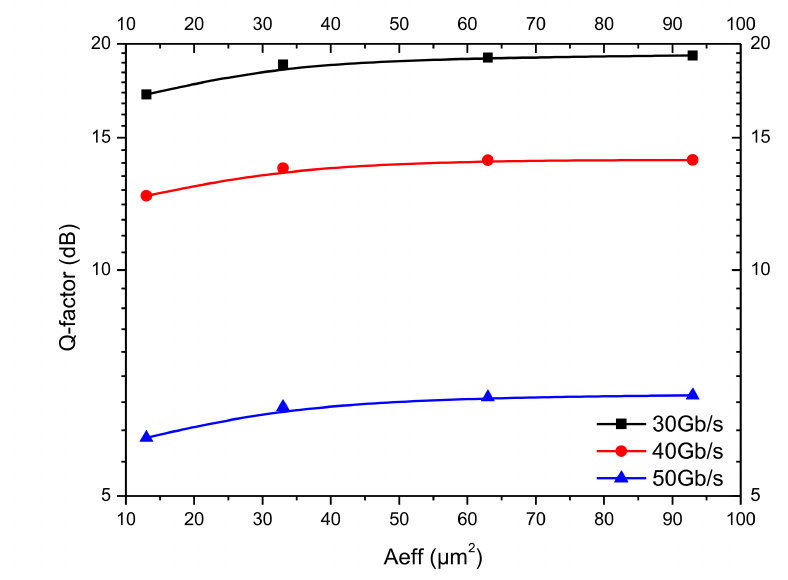
Figure 4. SAC-OCDMA system performance versus effective